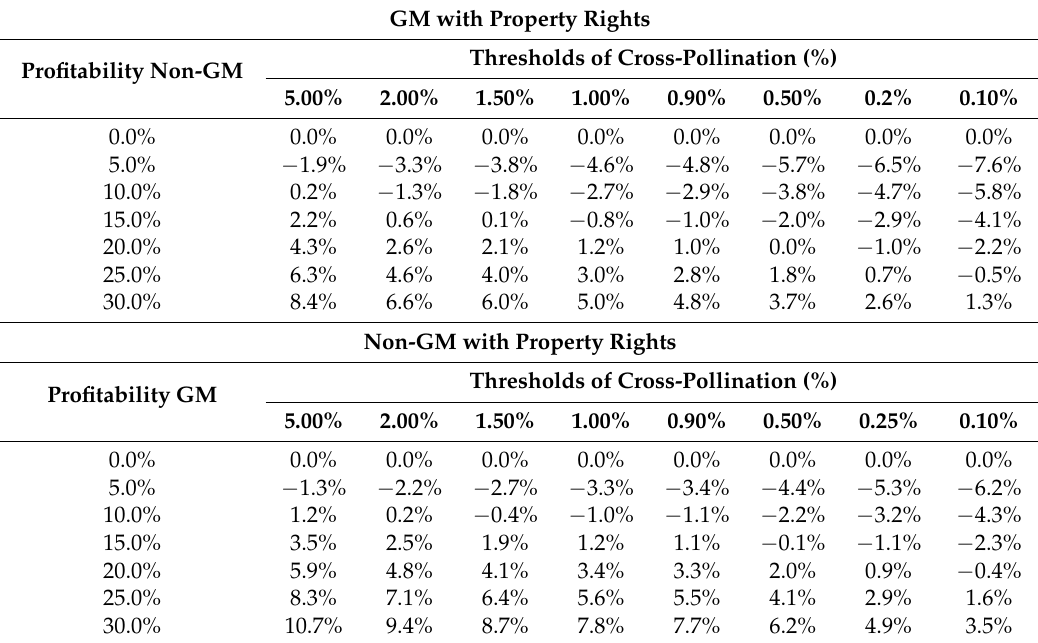
Table 4. Percentage variation in profits for the landscape relative to the baseline for alternative thresholds of cross-pollination when GM producers have the property rights and when the non-GM producers have the property rights. The European Union (EU) regulatory threshold of cross-pollination is